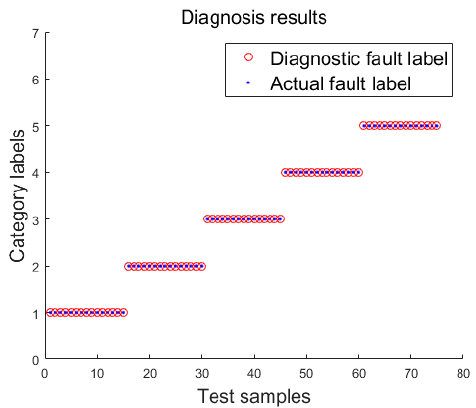
Figure 26. Classification result under variable conditions.